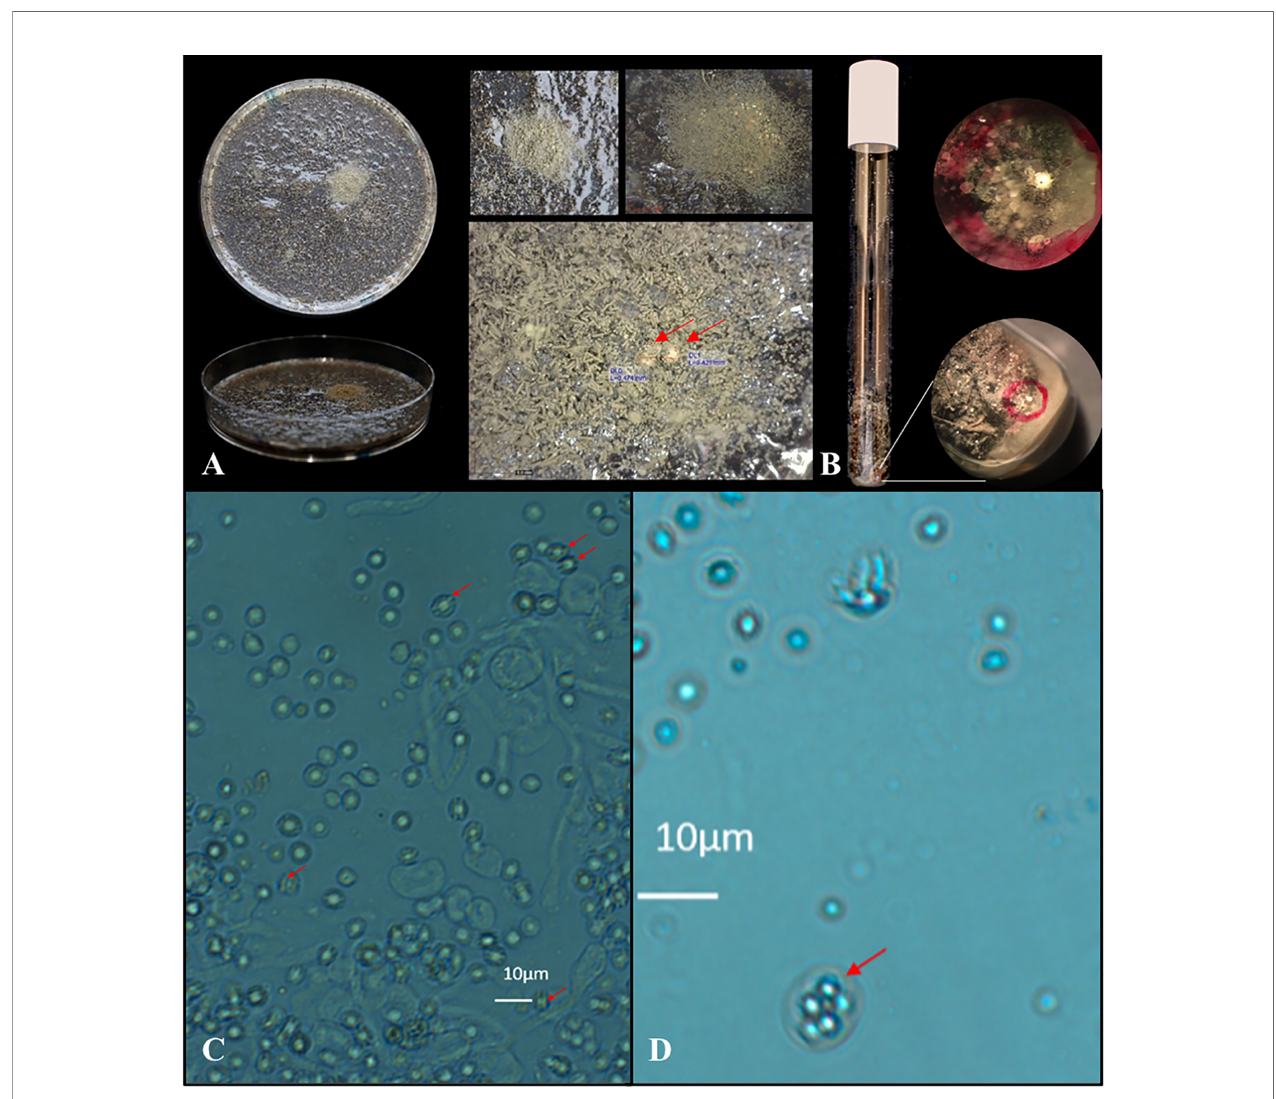
FIGURE 4 | Visual and microscopic detection of cleistothecia formed on fl ower bulb waste material. The petri dish crossing showed limited and patch like growth within the middle of the patch two visible cleistothecia ( A , red arrows). In the glass tube a cleistothecia was visible by visual inspection from the outside of the tube ( B , red circle). Cleistothecia were crushed and the suspensions showed typical ascospore phenotype by microscopic inspection with two equatorial crests ( C , red arrows) together with occasional intact asci ( D , red arrow) con fi rming a successful sexual crossing of A. fumigatus on sample #5 fl ower bulb waste